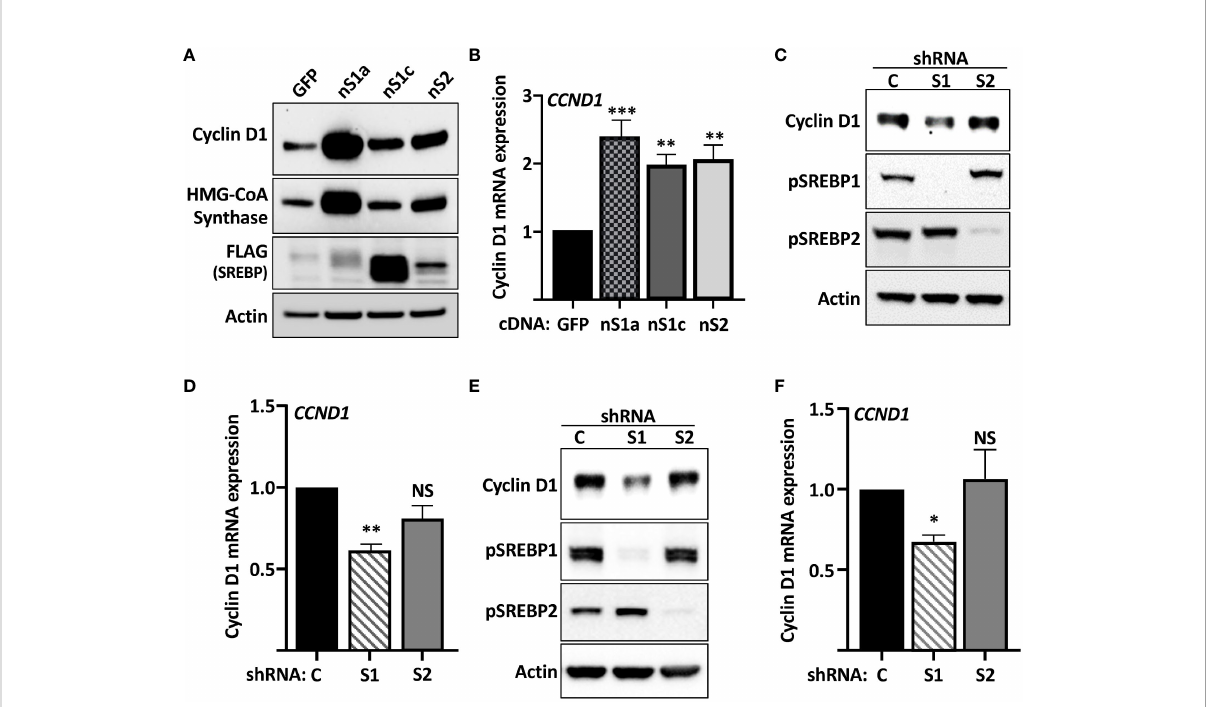
FIGURE 1 Cyclin D1 is regulated by members of the SREBP family of transcription factors. (A) HepG2 cells were transduced with lentiviruses encoding GFP or FLAG-tagged versions of the nuclear forms of SREBP1a ( nS1a ), SREBP1c ( nS1c ), or SREBP2 ( nS2 ). The levels of cyclin D1, HMG-CoA synthase, the nuclear forms of SREBP1a, SREBP1c and SREBP2 ( FLAG ), and b -actin in total lysates were determined by Western blotting. The quanti fi cations of cyclin D1 and HMG-CoA synthase across three independent experiments are included in Supplementary Figure S1. (B) HepG2 cells were transduced as in (A) , and mRNA was isolated and used to generate cDNA. The expression of cyclin D1 ( CCND1 ) was determined by real-time qPCR using GAPDH for normalization. (C) HepG2 cells were transduced with lentiviruses encoding shRNAs, either non-targeted (C) or targeting SREBP1 ( S1 ) or SREBP2 ( S2 ). The levels of cyclin D1 and the precursor forms of SREBP1 ( pSREBP1 ) and SREBP2 ( pSREBP2 ) were detected by Western blotting. b -Actin was used as a loading control. (D) HepG2 cells were transduced with shRNA as in (C) and the expression of cyclin D1 was determined by real-time qPCR. (E) MCF7 cells were transduced with shRNA as in (C) , and the levels of cyclin D1 and the precursor forms of SREBP1 ( pSREBP1 ) and SREBP2 ( pSREBP2 ) were detected by Western blotting. (F) MCF7 cells were transduced with shRNA as in (C) , and the expression of cyclin D1 was determined by real-time qPCR. Signi fi cance was determined by one-way ANOVA with Tukey ’ s multiple comparisons adjustment (B, D, and F) . p-values lower than 0.05 were considered statistically signi fi cant. *p < 0.05, **p < 0.01, ***p < 0.001, and ****p < 0.0001. NS , not signi fi